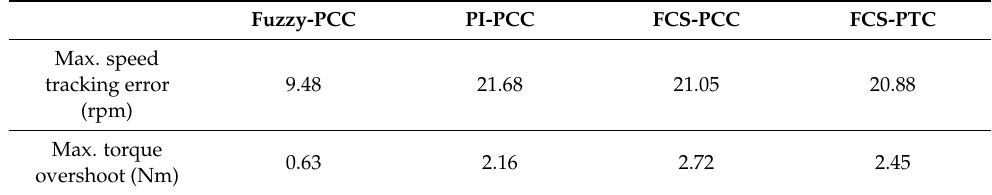
Table 5. Comparison of proposed method with other model predictive control methods.